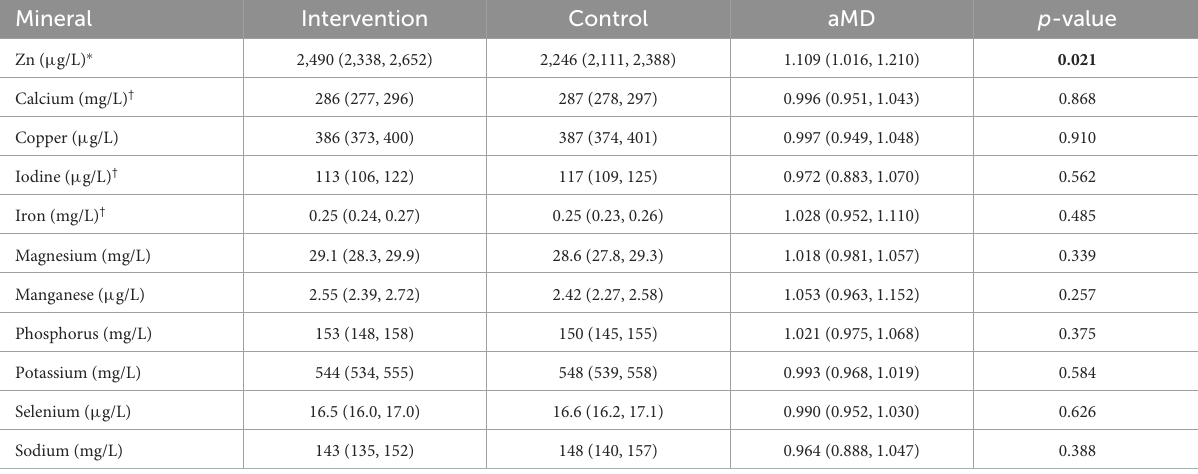
TABLE 5 Mineral concentrations in human milk (HM) over the first 3 months of lactation in the intervention and control groups. Mineral Intervention Control aMD